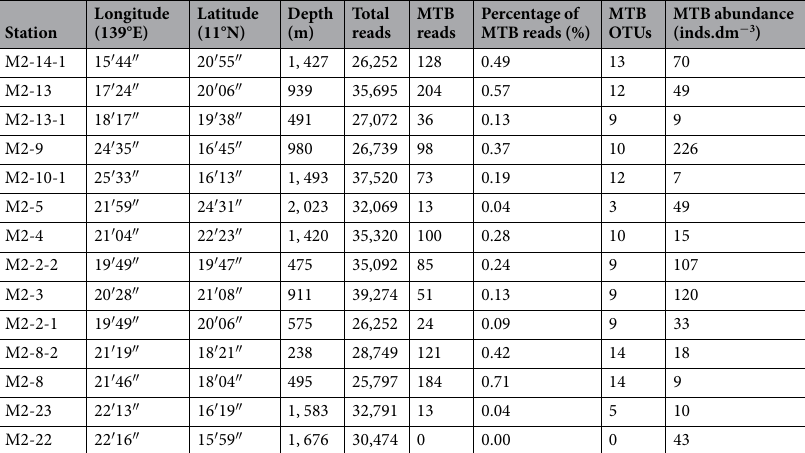
Table 1. MTB abundance and MTB reads at 14 stations at the Kexue seamount. Magnetotactic bacteria from the Kexue seamount were identified using two methods. MTB reads were obtained by metagenomics analysis. MTB abundance (inds./dm 3 ) was based on the number of live MTB directly observed by microscopy and adjusted to account for the volume of sediment from which the counts was